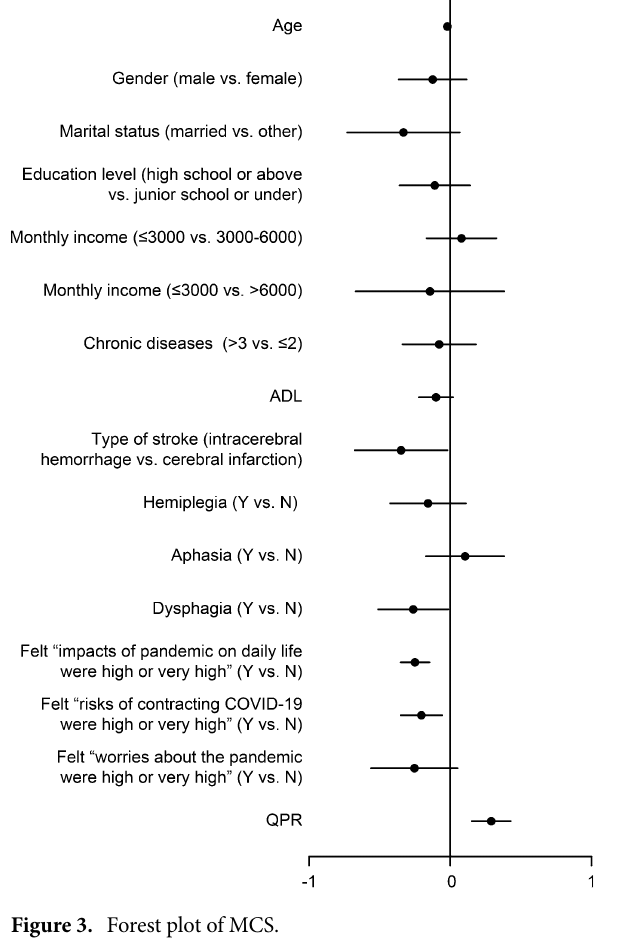
Figure 3. Forest plot of MCS.